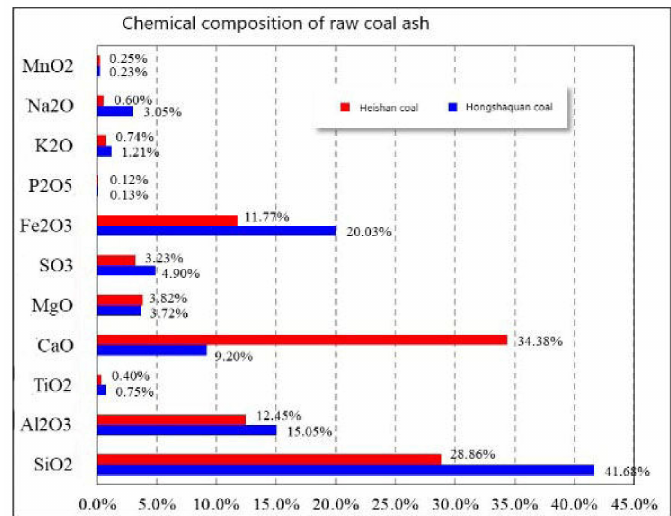
Figure 5. Chemical composition of raw coal